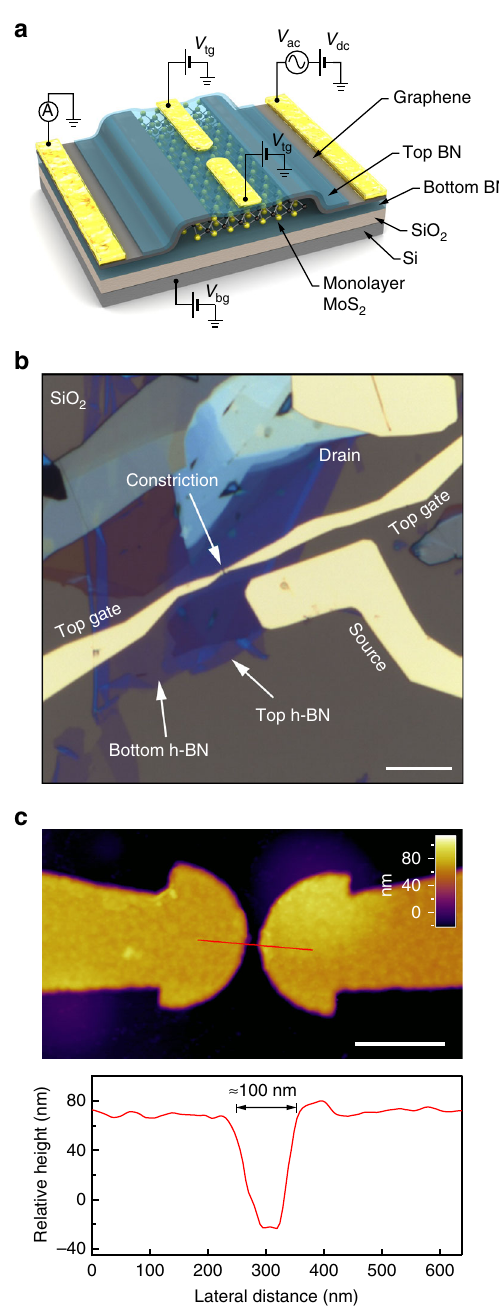
Fig. 1 Dual-gated encapsulated monolayer MoS 2 transistor. a The 3D schematics of the device shows all the layers in our device and the metallic electrodes. b An optical micrograph of the fi nal device after contact deposition. Scale bar is 10 µ m. c An AFM image of the split-gate geometry. Scale bar is 500 nm. Following the red line we measure a distance between the two top gates of about 100